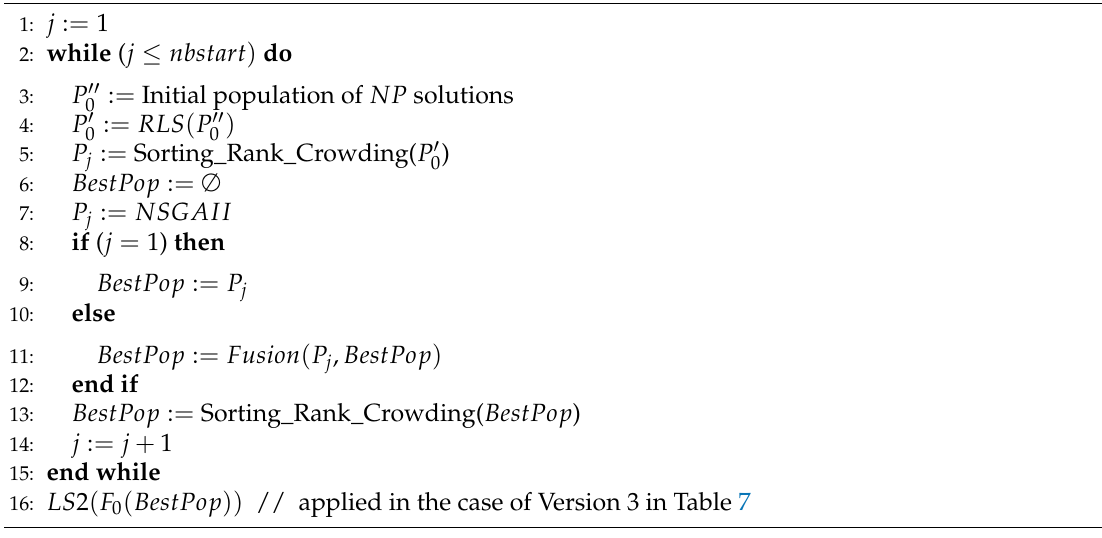
Algorithm 3 Multi-Start Non-Dominated Sorting Genetic Algorithm